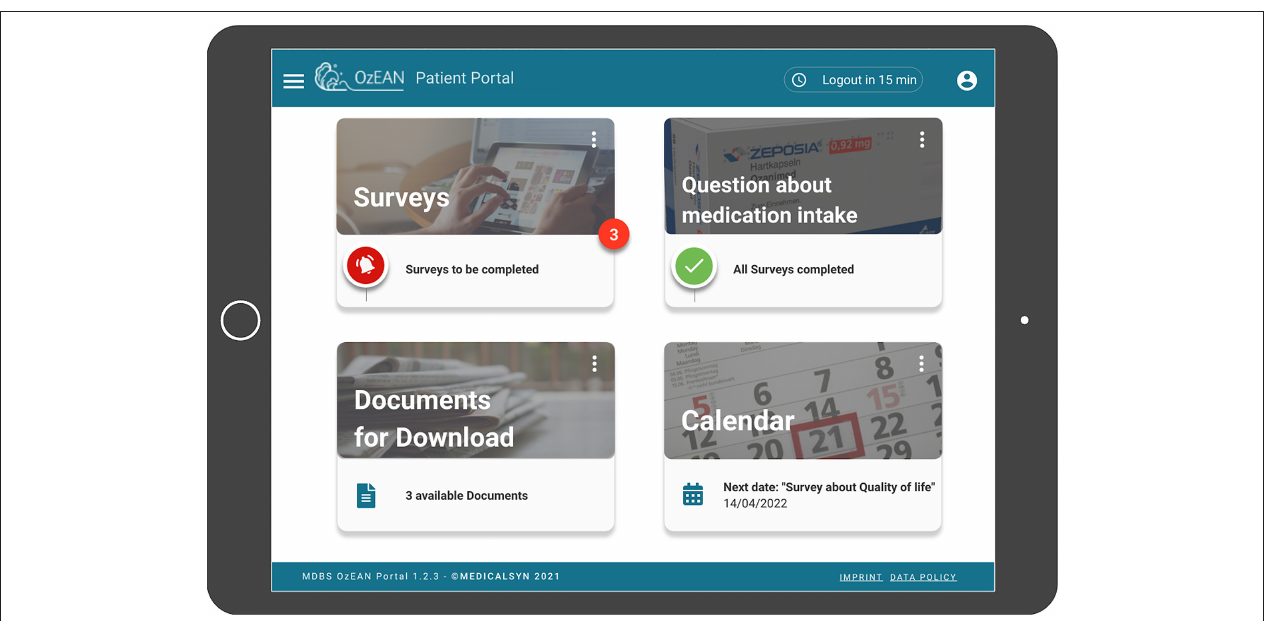
FIGURE 4 | OzEAN patient portal user interface. On the start page of the patient user interface, the patient can select from the following options: surveys (PROs), questions about medication intake (medication plan), documents for download, and calendar. The medication plan displays information on ozanimod treatment. The documents module provides downloadable files (e.g., patient portal user manual and ozanimod SmPC). The calendar displays the patient’s start date and participation within the OzEAN study and is equipped with a reminder to take ozanimod. The patient is also able to review and visualize personal longitudinal data graphically. PRO, patient-reported outcome; SmPC, Summary of Product